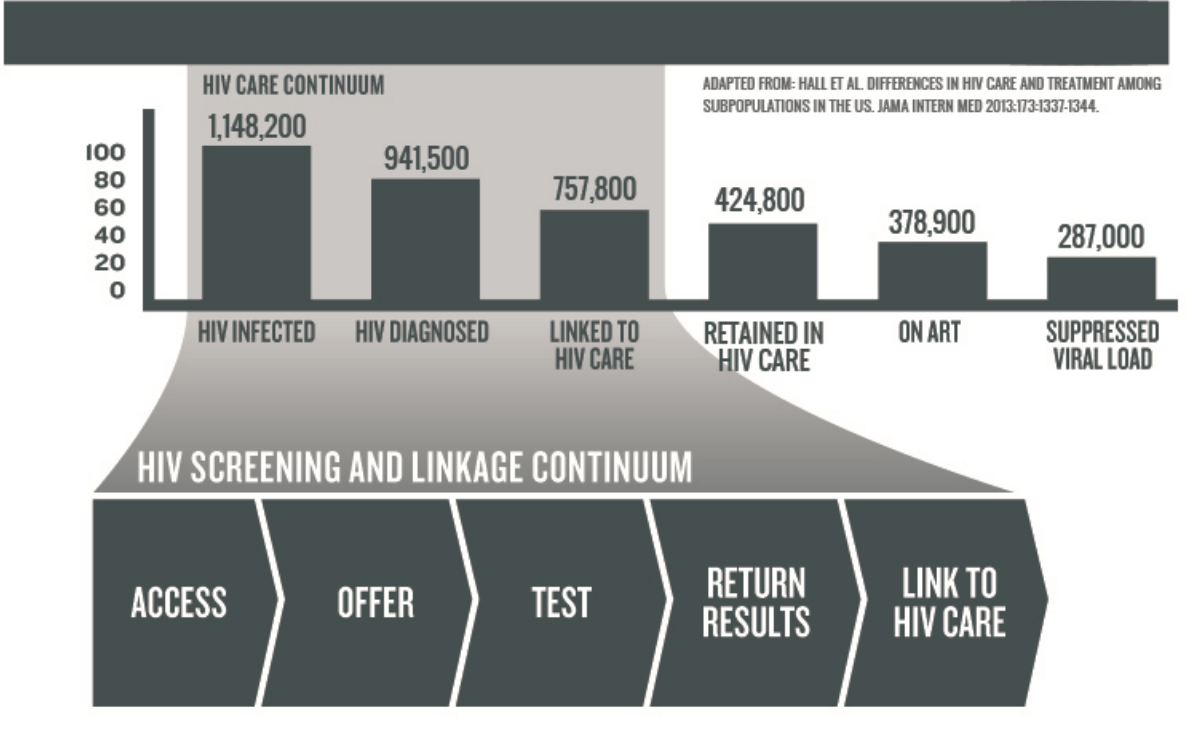
Figure 1. Routine HIV screening and linkage to